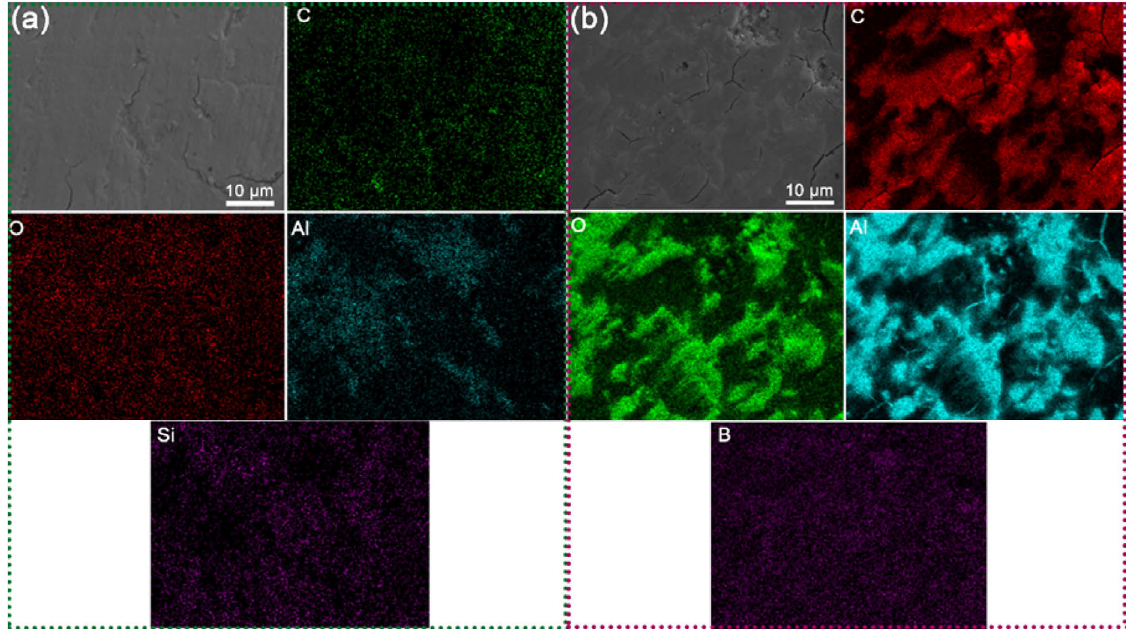
Fig. 14 Tribofilms and corresponding elemental mappings generated from (a) PI/SCF/SiO 2 and (b) PI/SCF/BN when sliding against Al 2 O 3 at 8